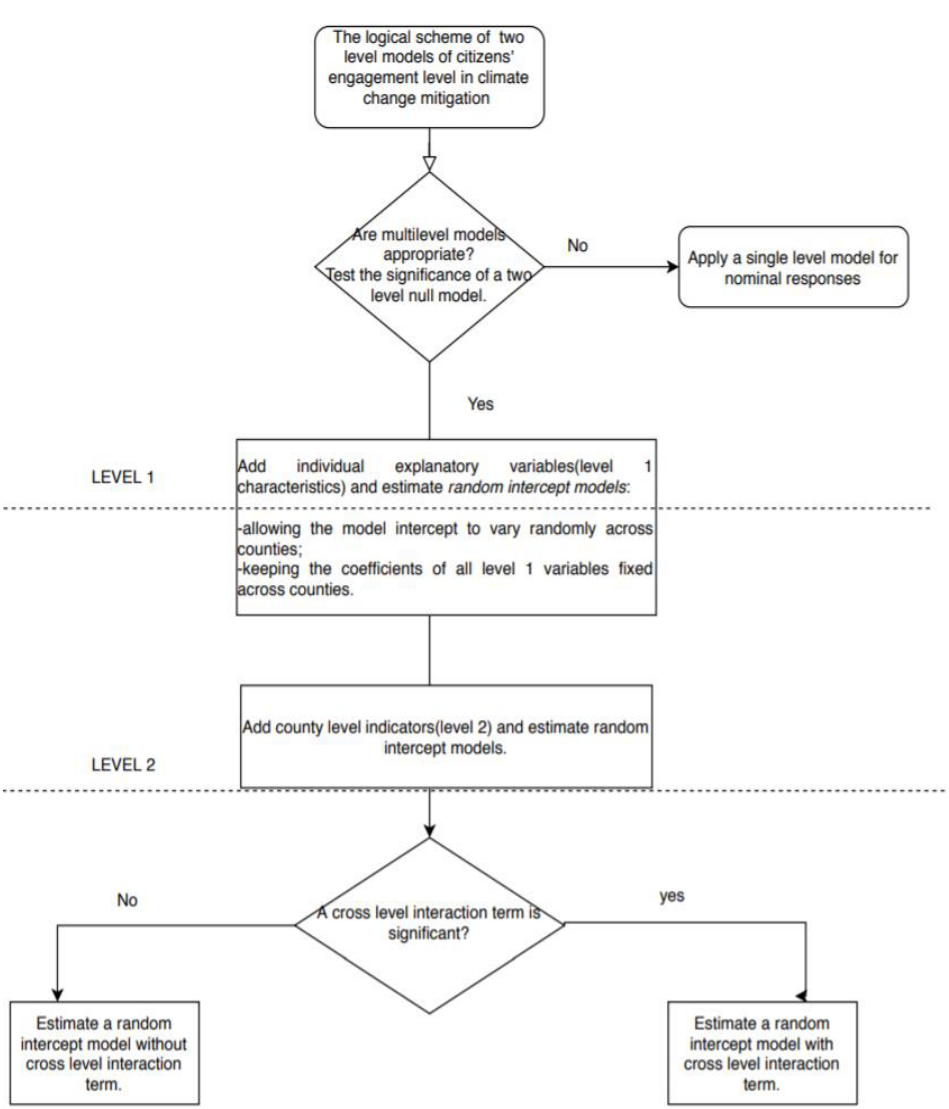
Figure 4. The logical scheme of two-level models for climate change mitigation behaviour. Source: Author’s contribution.